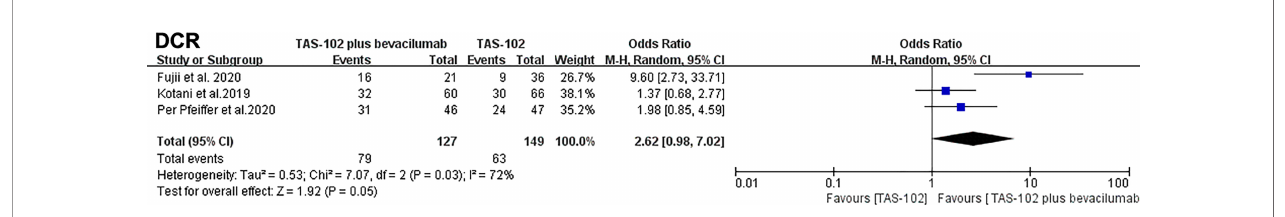
FIGURE 5 | Forest plot of pooled relative risk for disease control rates from included studies. Horizontal lines represent 95% con fi dence intervals (CIs). M-H, Mantel- Haenszel; df, degrees of freedom; DCR, disease